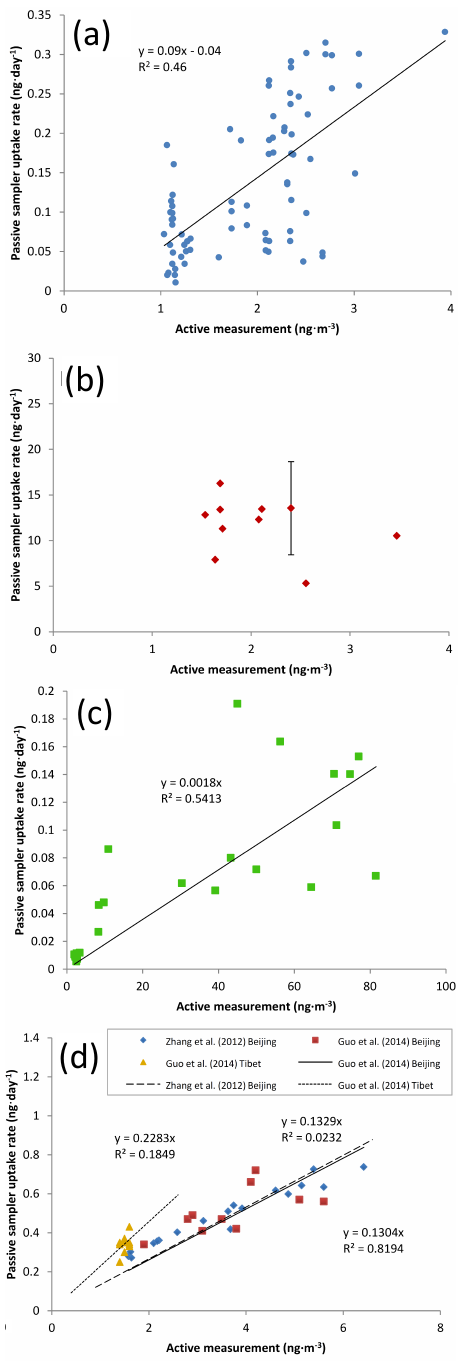
Figure 4. Passive sampler uptake rate (UR) plotted against the cor- responding mean actively measured GEM concentration. (a) Data for gold plate sorbents from Gustin et al. (2011); trend line was not forced through 0 by authors. (b) Data from Huang et al. (2012). (c) Data from Nishikawa et al. (1999); data above 100ngm − 3 were excluded to enable a focus on the PAS’s performance at relevant am- bient GEM concentrations (for full log–log scaled graph see origi- nal paper). (d) Data from Zhang et al. (2012) and Guo et al. (2014) for the same PAS design. Data from panels (a, b, c) were obtained using PlotDigitizer, Free Software,